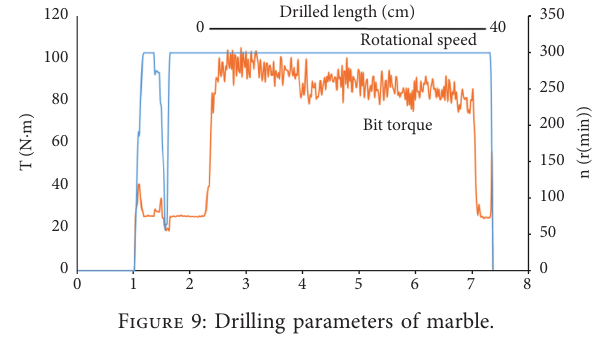
Figure 9: Drilling parameters of marble.